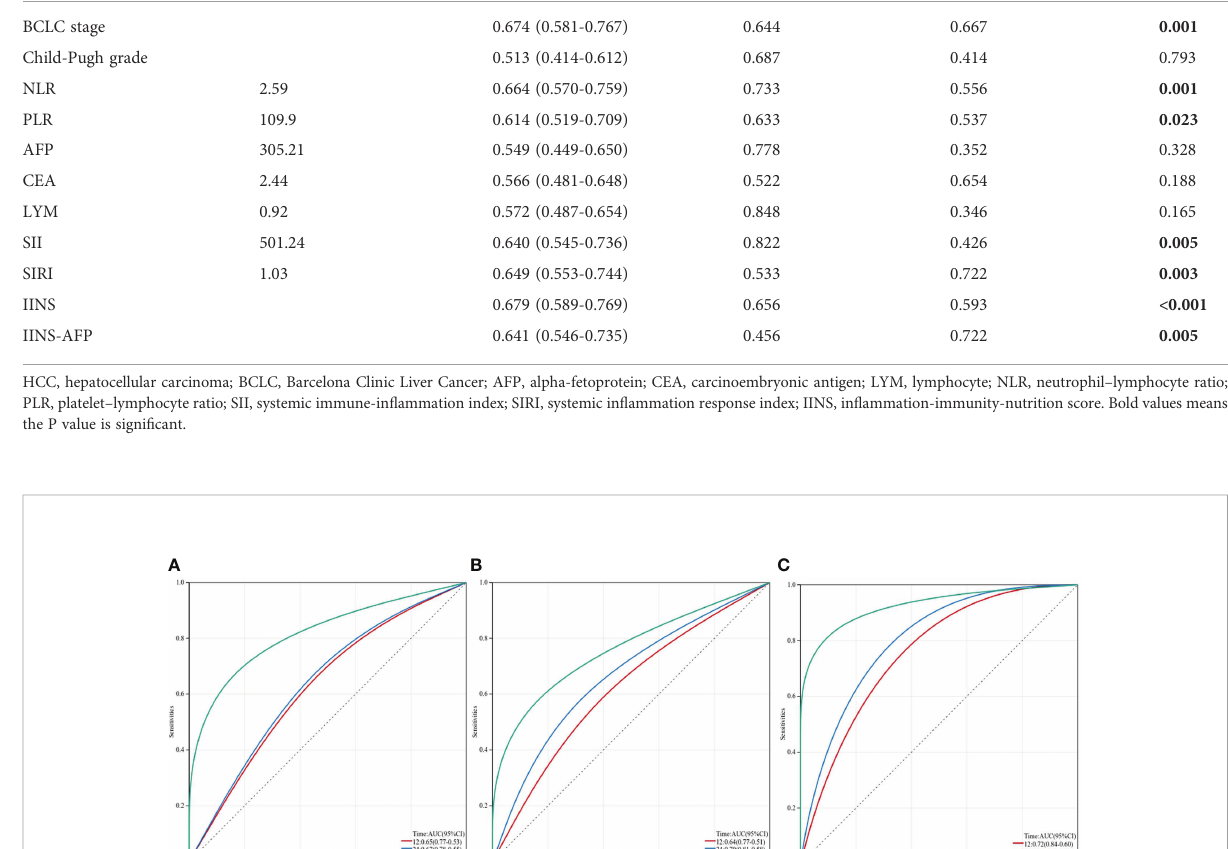
TABLE 5 Receiver operating characteristics analysis between IINS and other indicators in progression-free survival of the HCC patients.